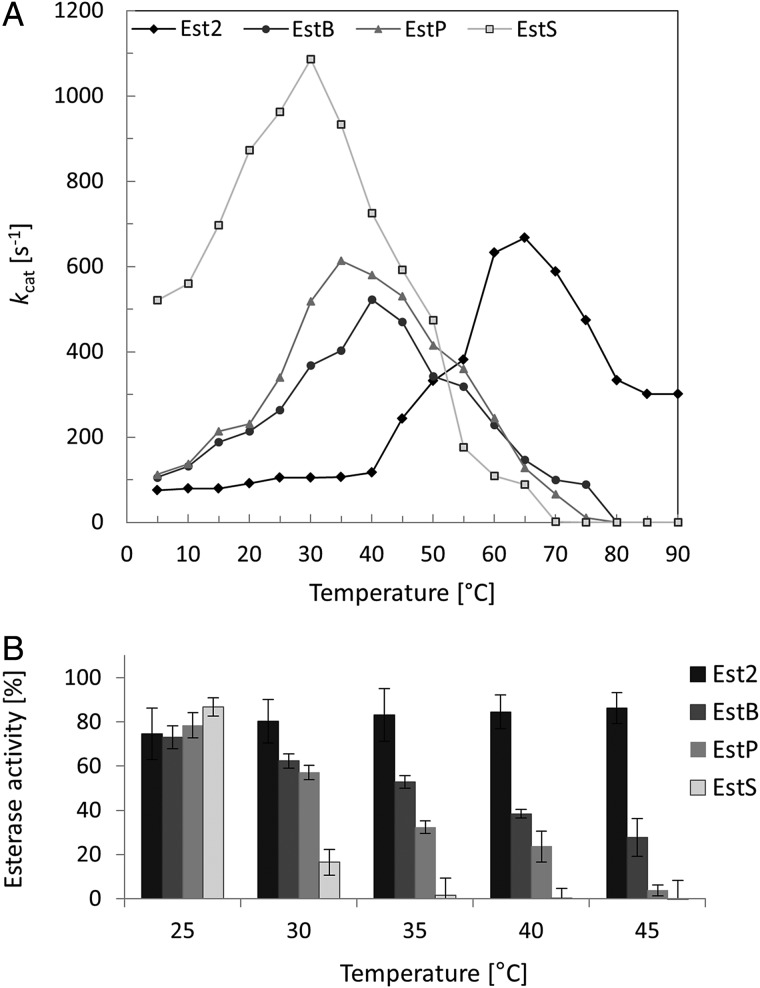
Effect of temperature on activity and stability of esterases Est2, EstB, EstP and EstS. (A) The temperature optima were determined with p-nitrophenyl butyrate as the substrate at temperatures ranging from 5°C to 80°C. For comparison, Est2 values were divided by 10. Data are mean values of at least three independent measurements with standard deviations <10%. (B) The thermal stability of esterases Est2, EstB, EstP and EstS was determined after 1 h incubation at 5–80°C followed by measuring the residual activities with p-nitrophenyl butyrate as the substrate at 30°C. Esterase activity is expressed as percentage of the activity of samples before incubation. Data are mean values of at least three independent measurements with bars indicating the standard deviations.